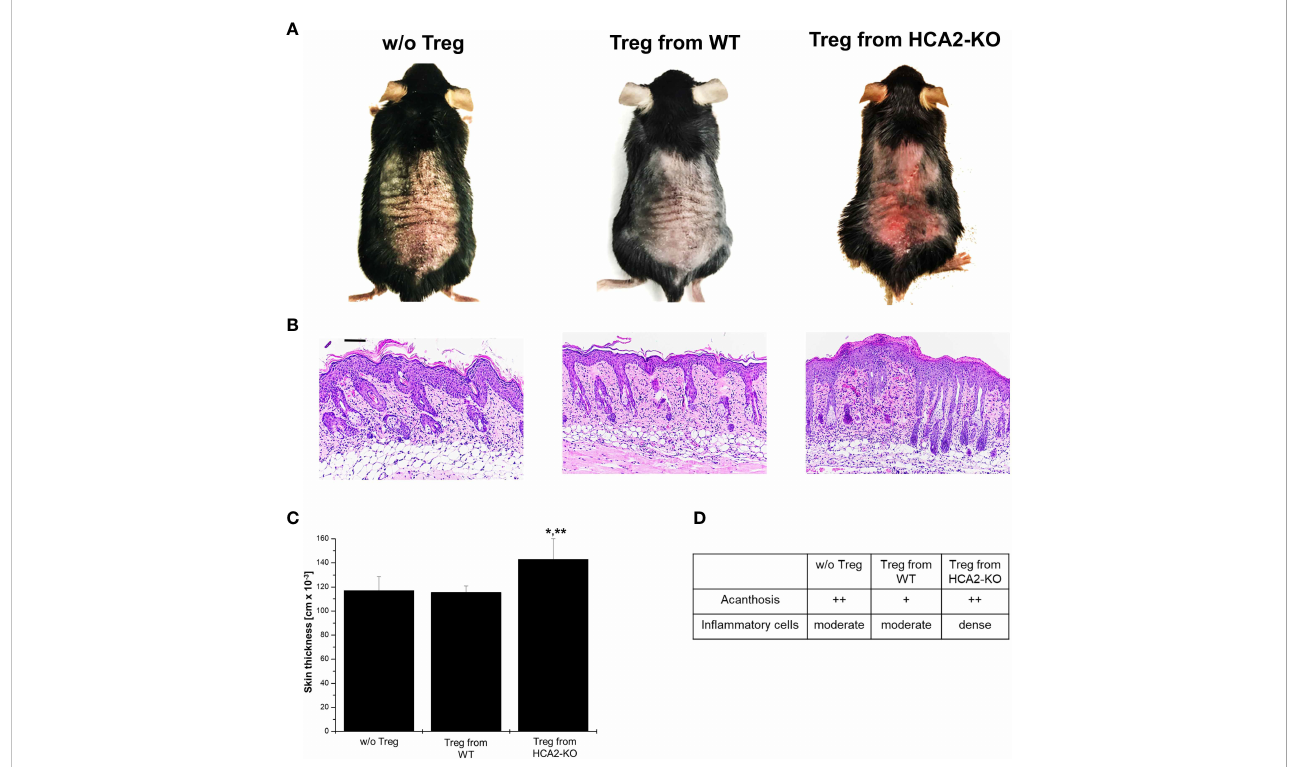
FIGURE 3 HCA2 signaling regulates the suppressive activity in vivo (A) Treg were isolated from pooled spleens and LN of WT or HCA2-KO mice and injected i.v. into IMQ-treated WT animals. (B) Biopsies obtained from IMQ-treated animals were taken. The paraf fi n embedded sections were stained with H&E and analyzed histopathologically. Each group contained 7 animals. Scale bar = 100 µm (C) The skin thickness was measured using a spring-loaded micrometer. Student t test and one-way ANOVA was performed. *P < 0.02 Treg from WT vs Treg from HCA2-KO, **P < 0.02 Treg from HCA2-KO vs w/o Treg; P ANOVA = 0.00872. (D) Acanthosis and density of in fl ammatory in fi ltrate were scored. Data are presented from one of three independent